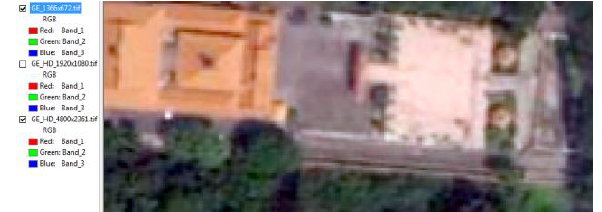
Figure 13a. Johor DEM with 12m resolution (937.34Mb)